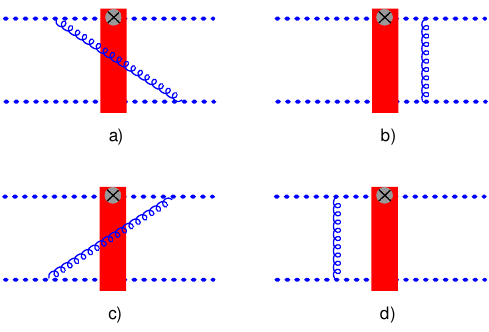
Figure 7 . Diagrams with sub-eikonal operator in the shock-wave. The gray circle with a cross on it represents the operator being treated as classical thus is situated in the red-band